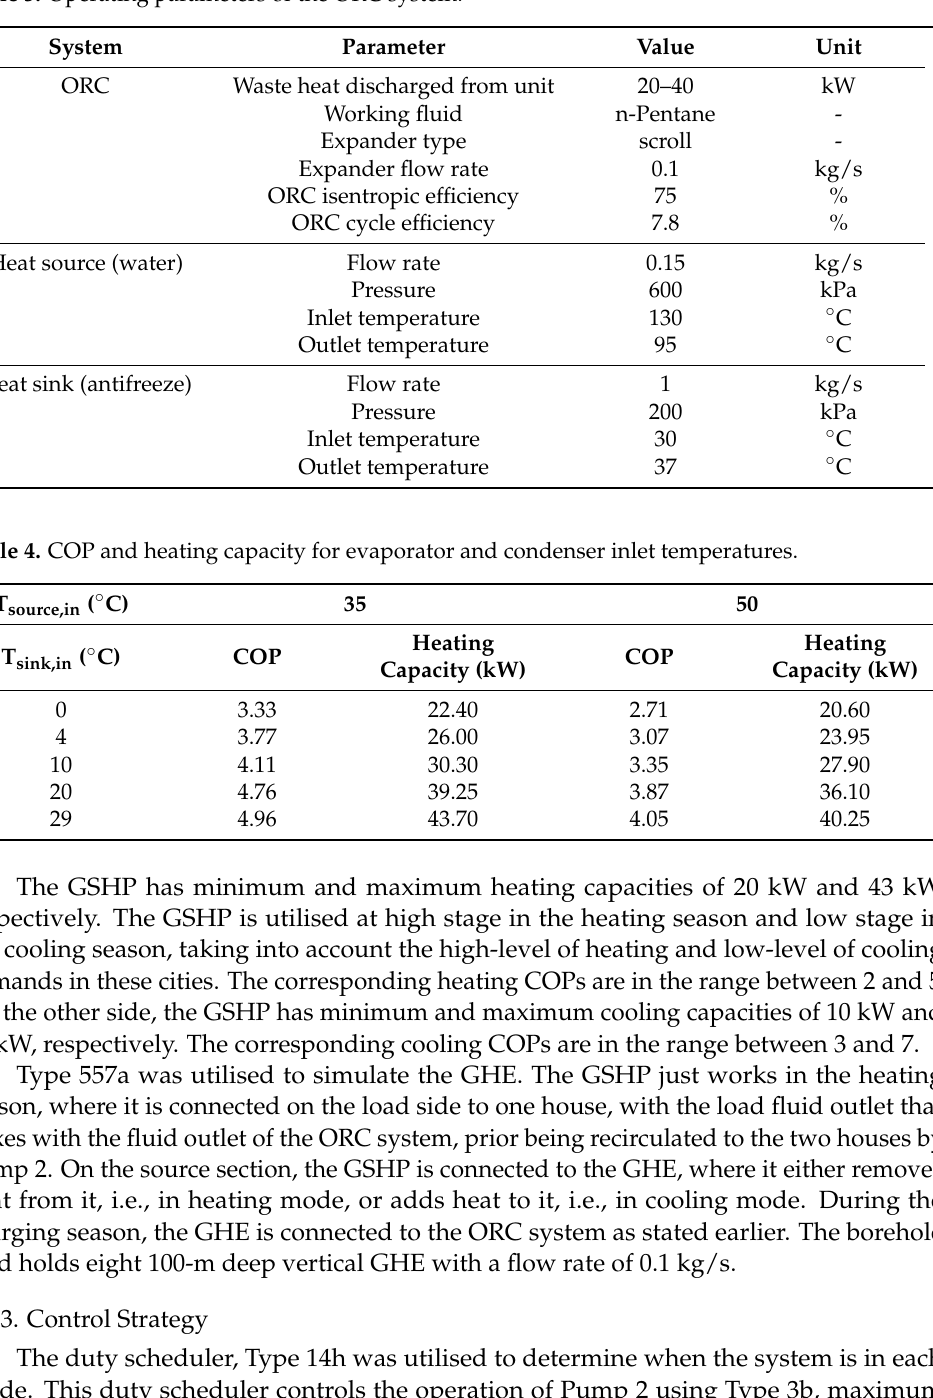
Table 3. Operating parameters of the ORC system.